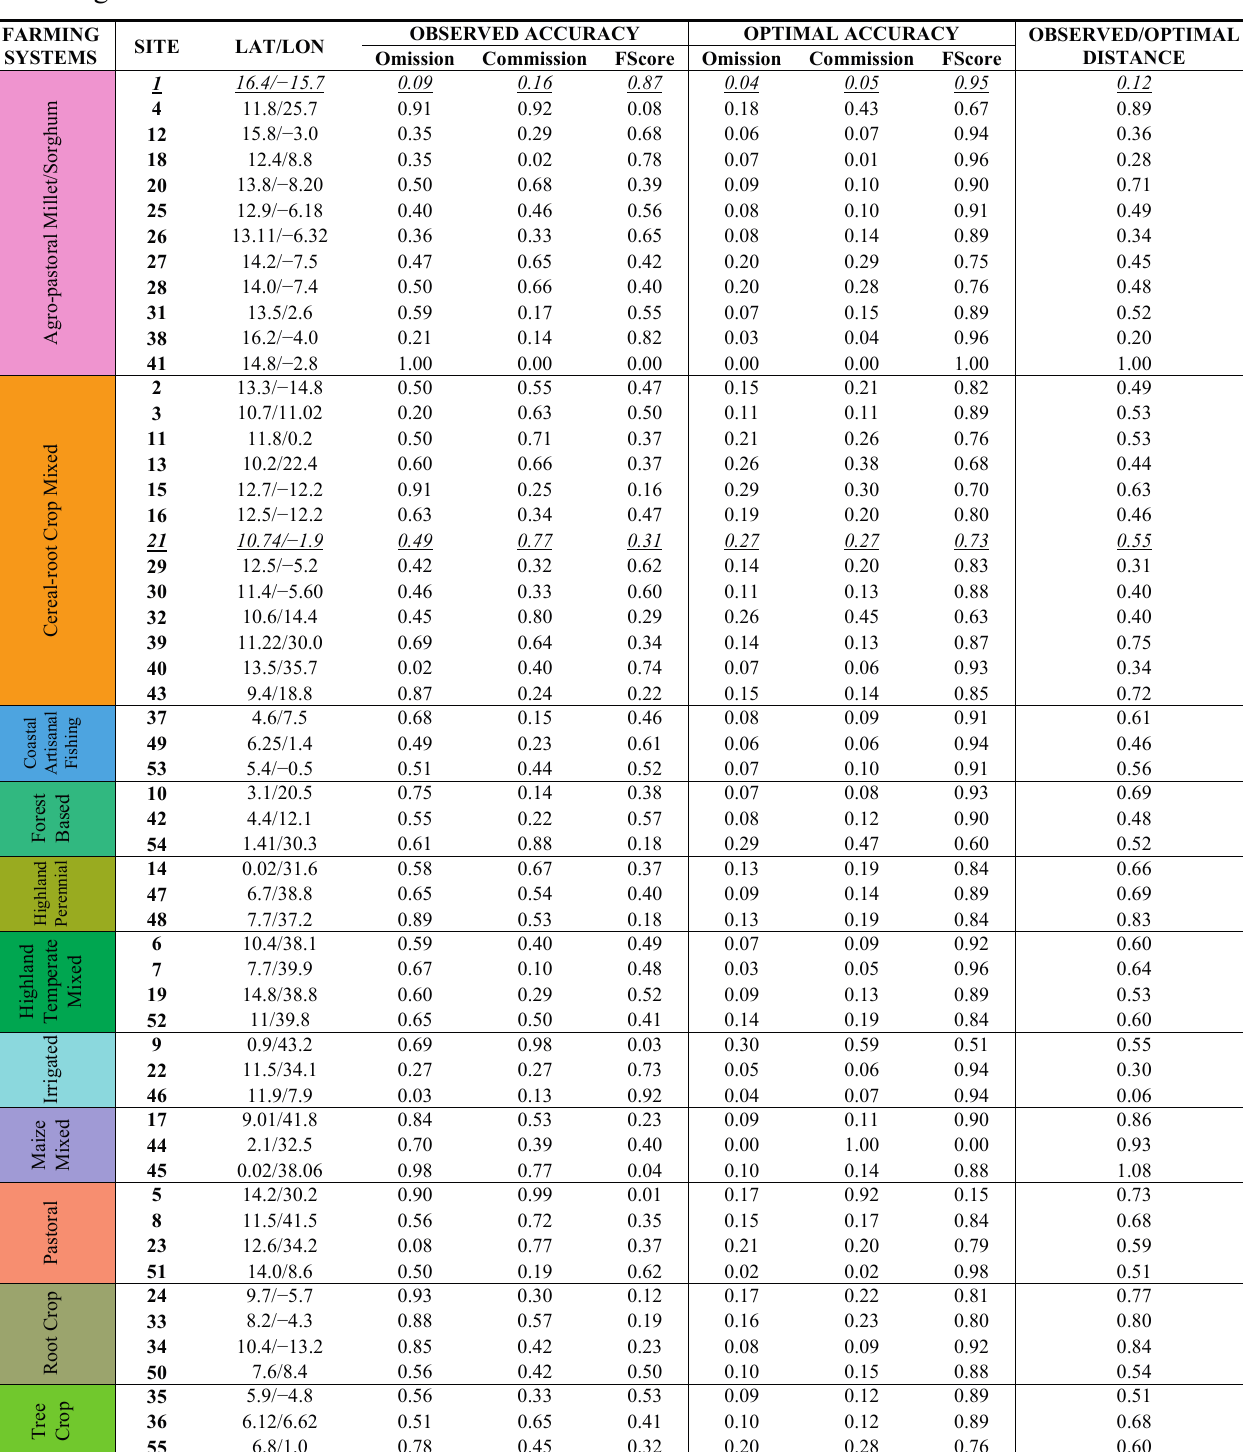
Table 2 . Accuracy matrices between the MODIS LCP and high-resolution classifications for crops and the 55 validation sites ranked by farming systems. The observed accuracy represents the actual accuracy, and the “optimal” accuracy extracted from the Pareto Boundary represents the potential accuracy that could be attained by the MODIS LCP given the low-resolution bias. The sites underlined and in italics are the two sites shown in Figure